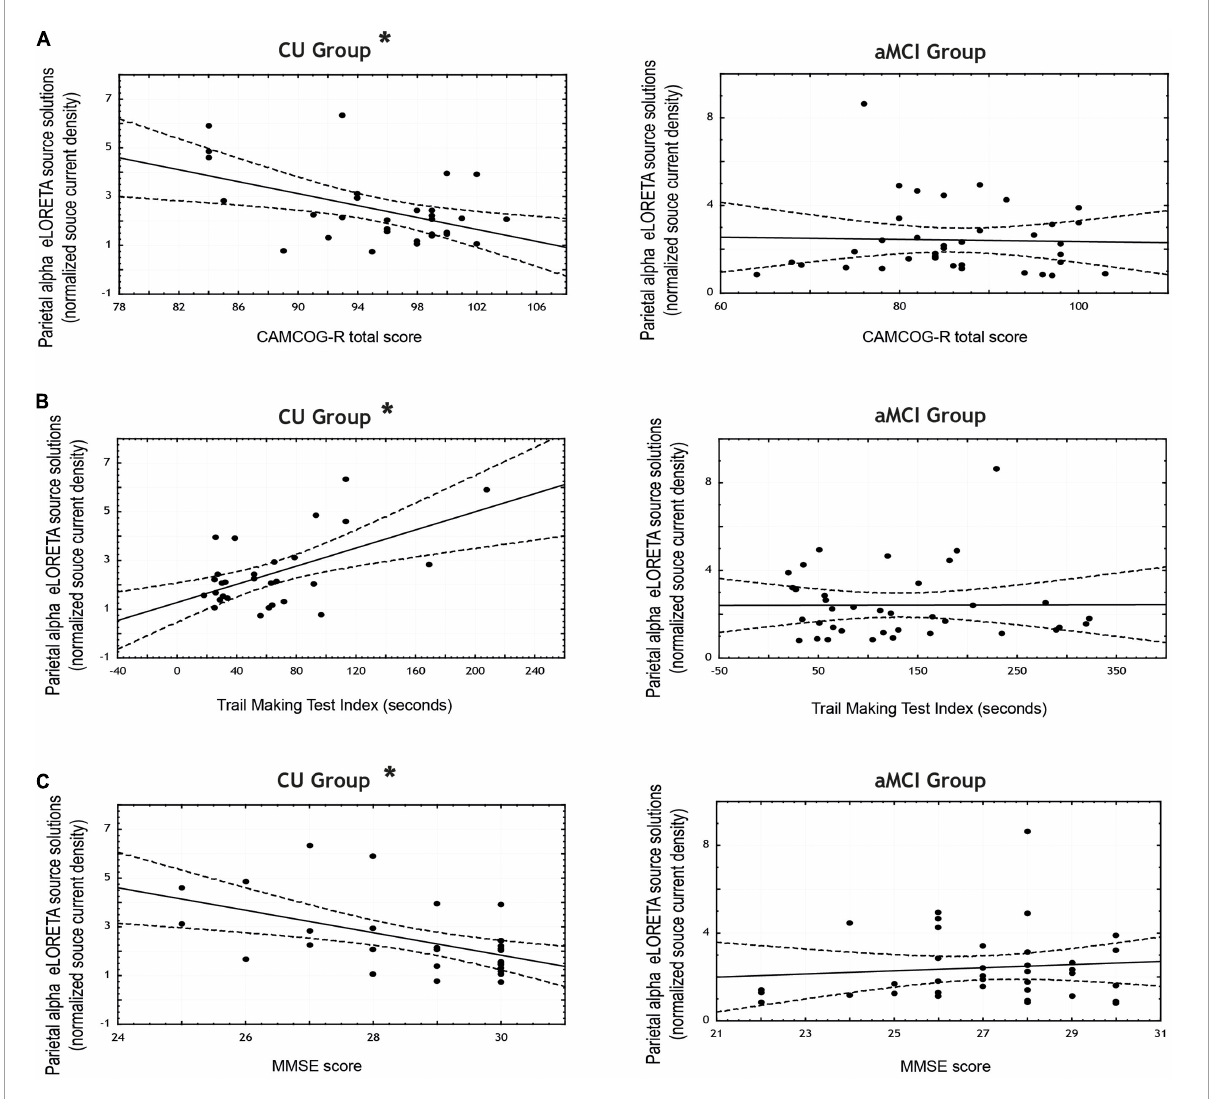
FIGURE4 Scatterplots for the CU and aMCI groups showing the correlations between eLORETA source solutions (normalized alpha current source density) of parietal alpha resting state EEG (rsEEG) rhythms and the scores in the neuropsychological tests: (A) CAMCOG total score; (B) Trail Making Test Index (in seconds); and (C) MMSE score. Note that * indicates significant correlations ( p < 0.05 and r >